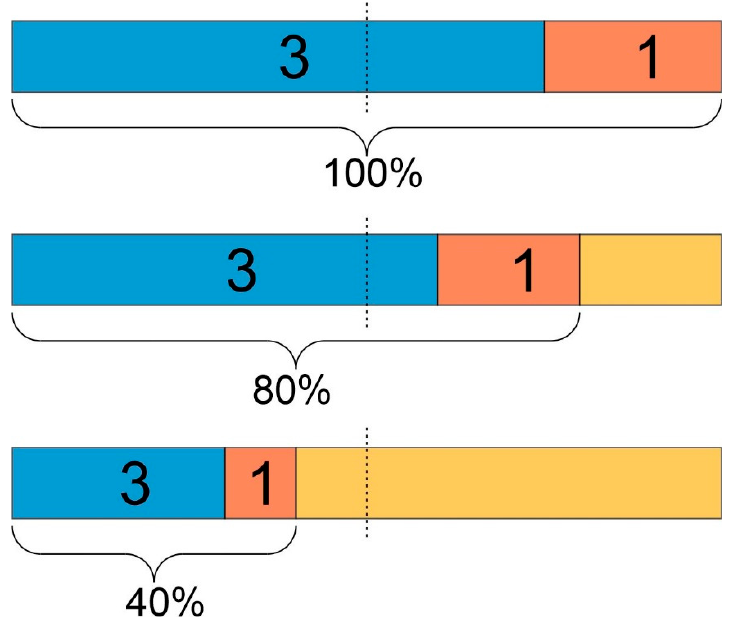
Figure 8. Uncertainty puts probabilities into perspective. Smaller voter turnout (e.g., 80%, 40%) in elections compares to increased uncertainty in DST. Dashed lines indicate 50%. From the very same ratio of votes for pro and contra (3:1 in each scenario), different consequences may be drawn in the light of high or low voter turnout, respectively. Likewise, probabilities of diagnoses may only be considered reliable if uncertainty, according to DST, is below some